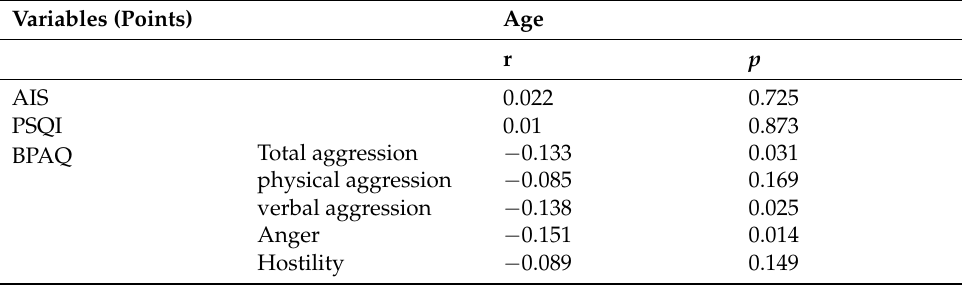
Table 3. The influence of age on sleep disorder and aggression. Variables (Points)